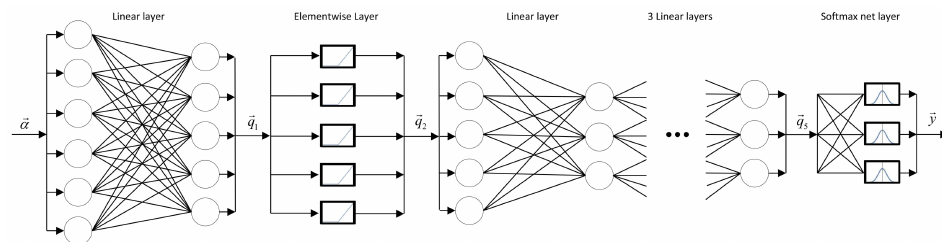
Figure 4. Architecture of the neural